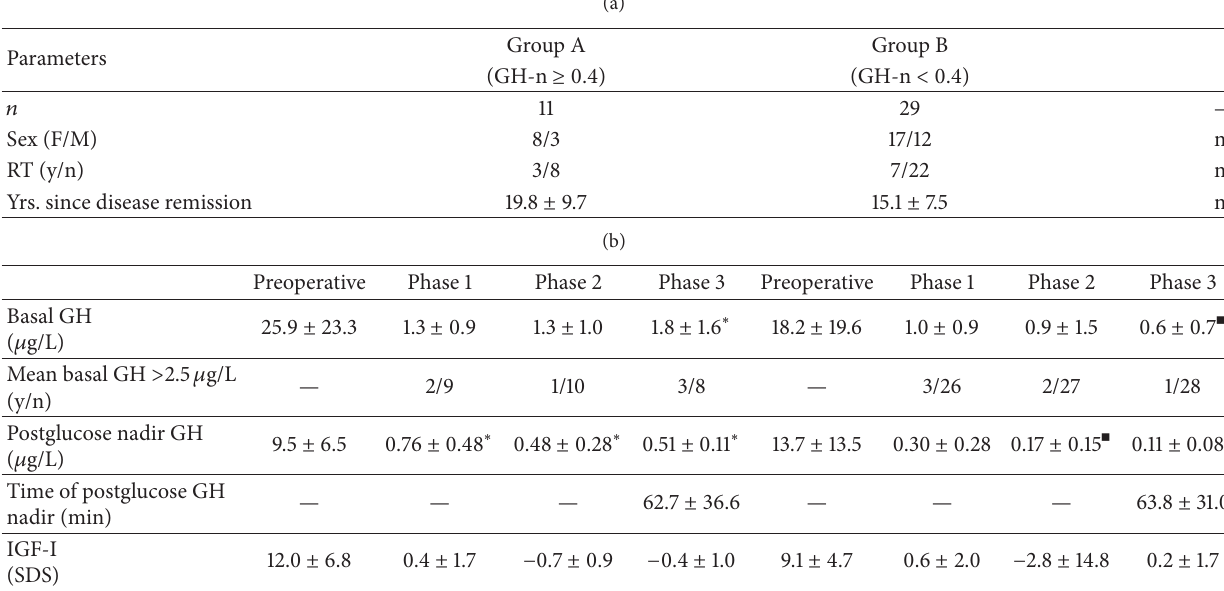
Table 2: Comparison of hormonal data between patients with postglucose GH nadir over (group A) and below 0.4 mcg/L (group B) during longitudinal follow-up. Mean ± SD values are